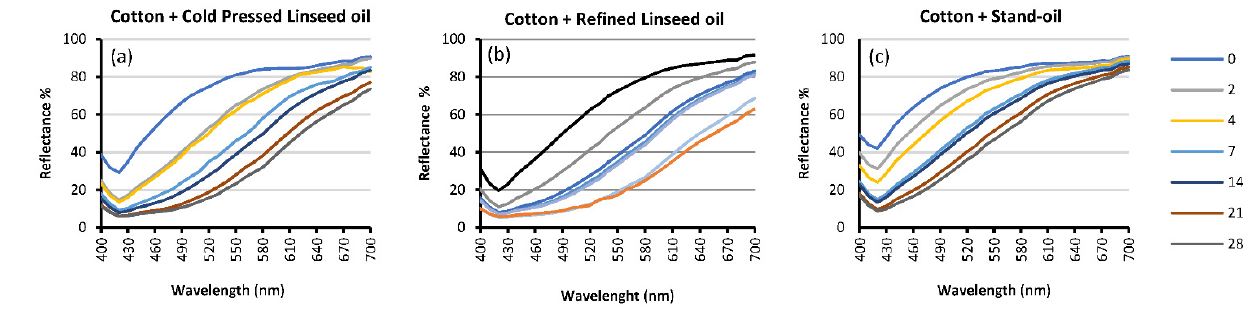
Figure 2. Reflectance graphs of all sets of mock-ups, including measurements of 0, 2, 4, 7, 14, 21, and